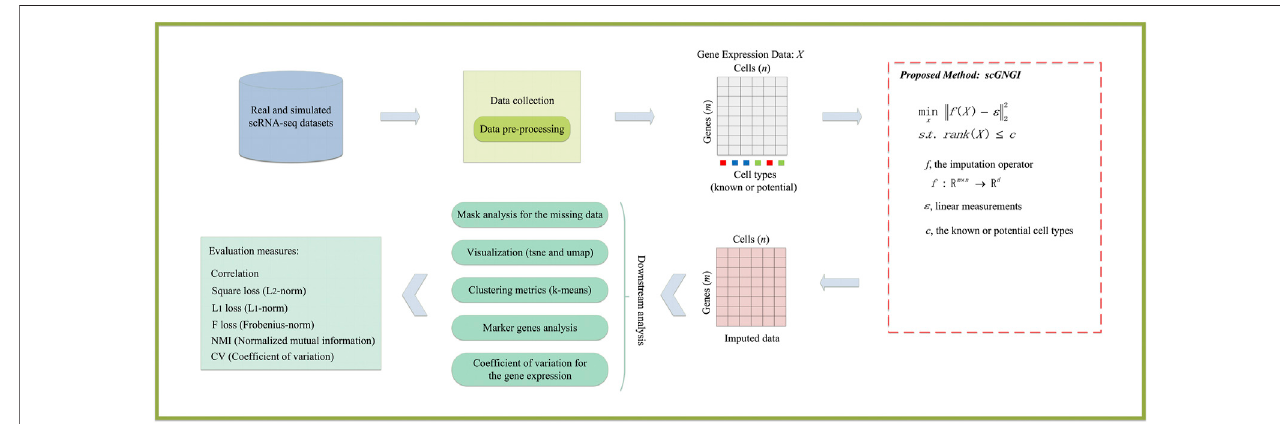
FIGURE 1 | Overview of the proposed scGNGI for single-cell RNA-seq imputations and downstream evaluations.